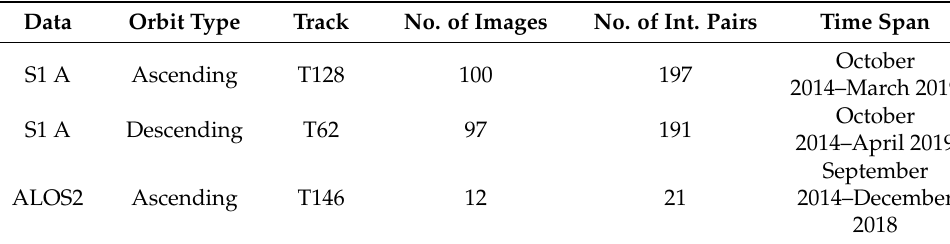
Figure 7. ( a ) Study area; ( b ) SAR data coverage area. The white dashed box represents the Sentinel-1 ascending data, and the black dashed box represents the Sentinel-1 descending data. The blue dashed box represents the ALOS2 ascending data. Table 1. Three kinds of data for SBAS interference pair information.